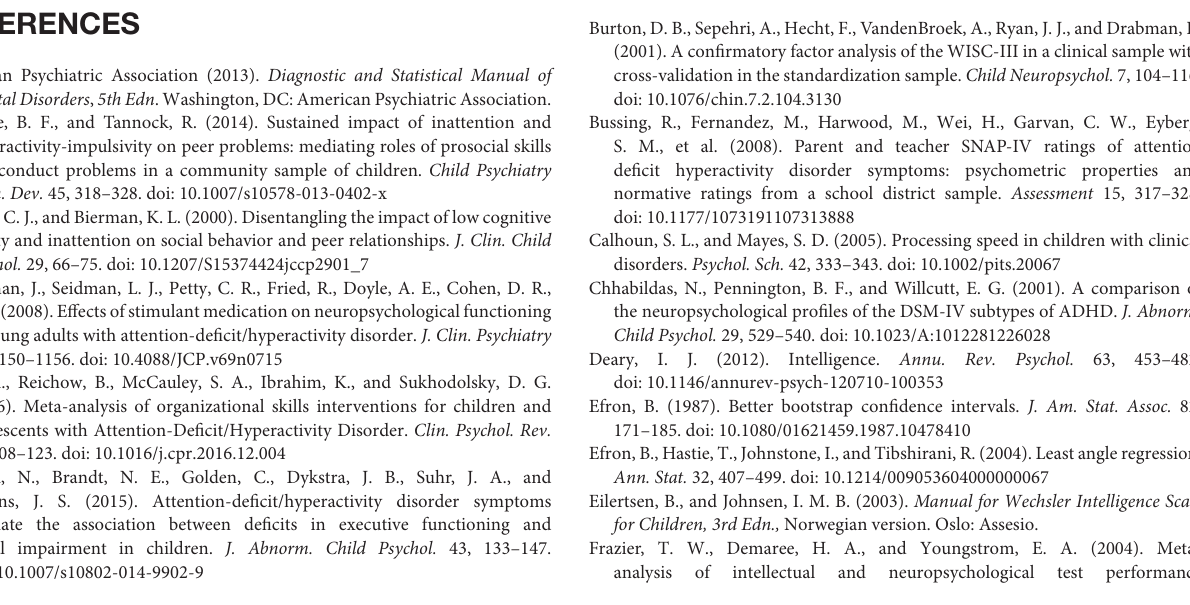
Supplementary Figure 1 | Distribution of mental disorders in the sample. Bars show the number of children meeting diagnostic criteria for mental disorders other than ADHD. The anxiety category includes specific phobia (eight with ADHD, 11 without ADHD), social phobia (one with ADHD, six without ADHD), generalized anxiety disorder (one with ADHD, one without ADHD), obsessive-compulsive disorder (one without ADHD), and panic disorder (one without ADHD). The mood category includes dysthymia (two without ADHD) and adjustment disorder (one without ADHD). Conduct disorders include oppositional defiant (seven with ADHD, four without ADHD) and conduct disorders (one with ADHD, one without ADHD). The TS/tic disorder category include Tourette’s Syndrome (four with ADHD, two without ADHD) and tic disorders (four with ADHD, seven without ADHD), while the category for other disorders includes enuresis/encopresis (six with ADHD, two without ADHD), alcohol abuse (one without ADHD), and intellectual disability (one with ADHD, one without ADHD) and unspecified other disorder (four with ADHD). Supplementary Table 1 | Distribution of parental